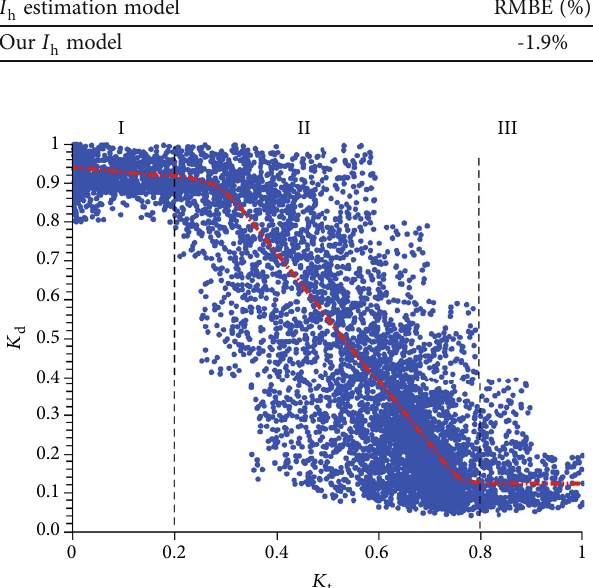
Figure 3: Hourly correlation between K index K t ð I h / I oh Þ